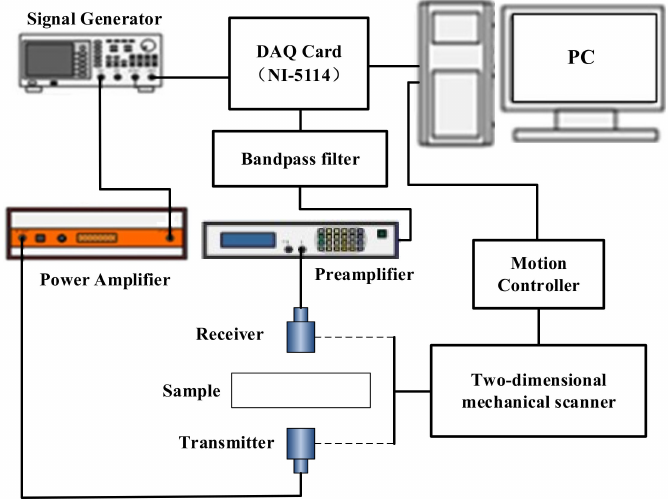
Figure 6. Schematic diagram of experimental setup; DAQ: Data Acquisition; PC: Personal